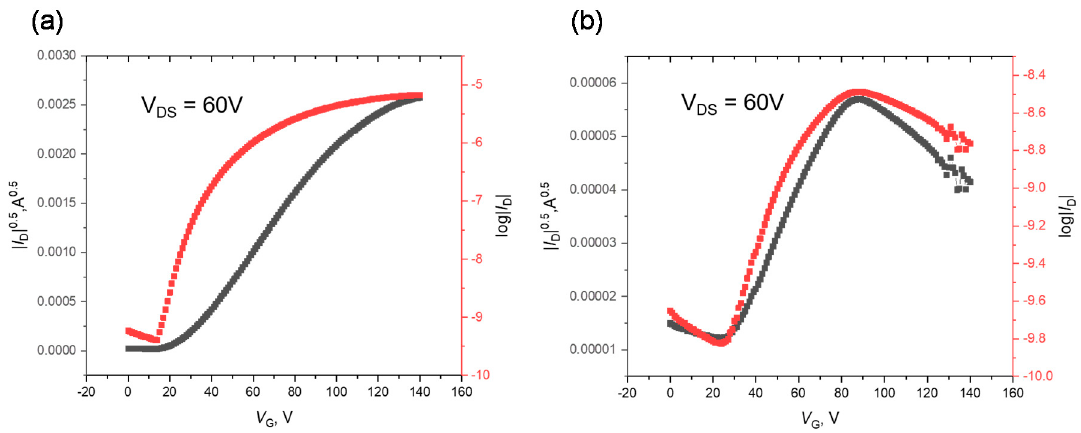
Figure 6. Transfer characteristics of thin film transistors based on polymer thin films of ( a ) PBDOPV-BTT after annealing at 240 ◦ C and ( b ) PBDOPV-BTTz after annealing at 210 ◦ C ( L = 100 µ m and W = 1000 µ m). Table 2. Summary of thin film transistor performances (best performance hence highlighted). Annealing Temp. ( ◦